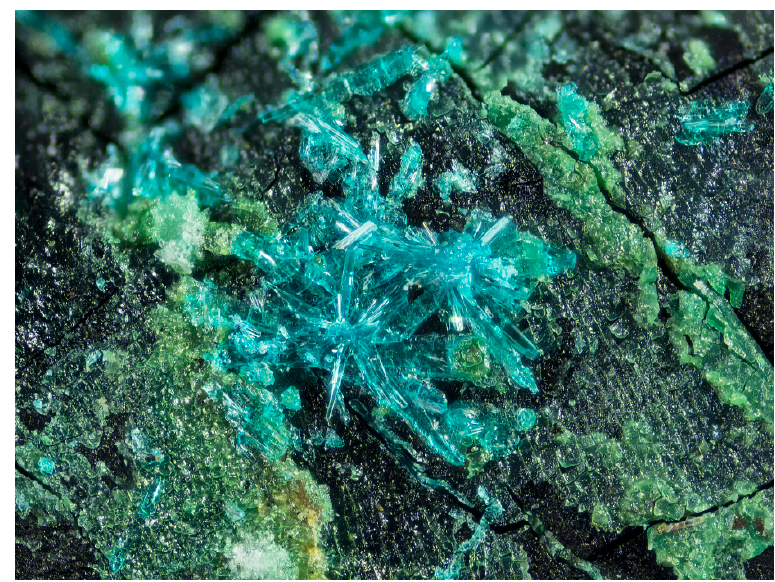
Figure 1. Fiemmeite aggregates with olivenite on coalified wood (base width 4 mm).